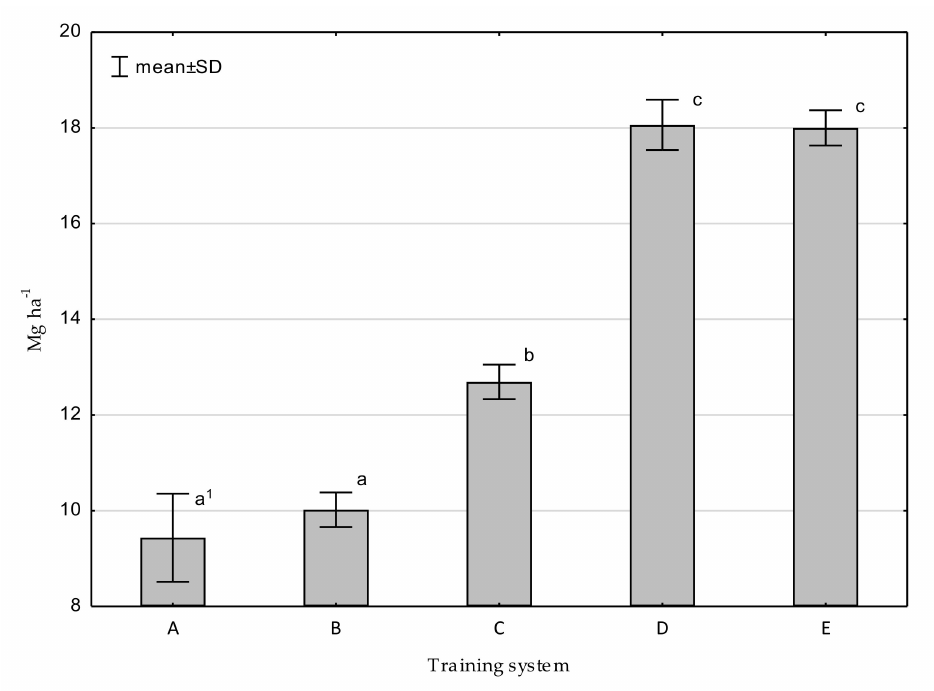
Figure 2. Average yield of fresh fruit per training system (A, B, C, D, E) in the years 2005–2020. 1 Means with different letters are significantly different, according to Tukey test ( p ≤